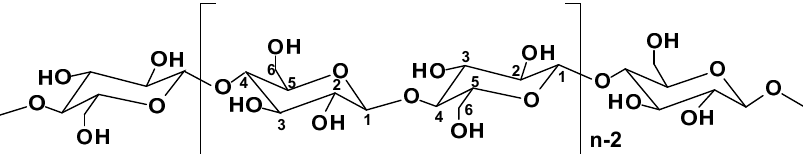
Figure 2. The molecular structure of cellulose ( n = DP; the carbon positions of the ring structure are marked).